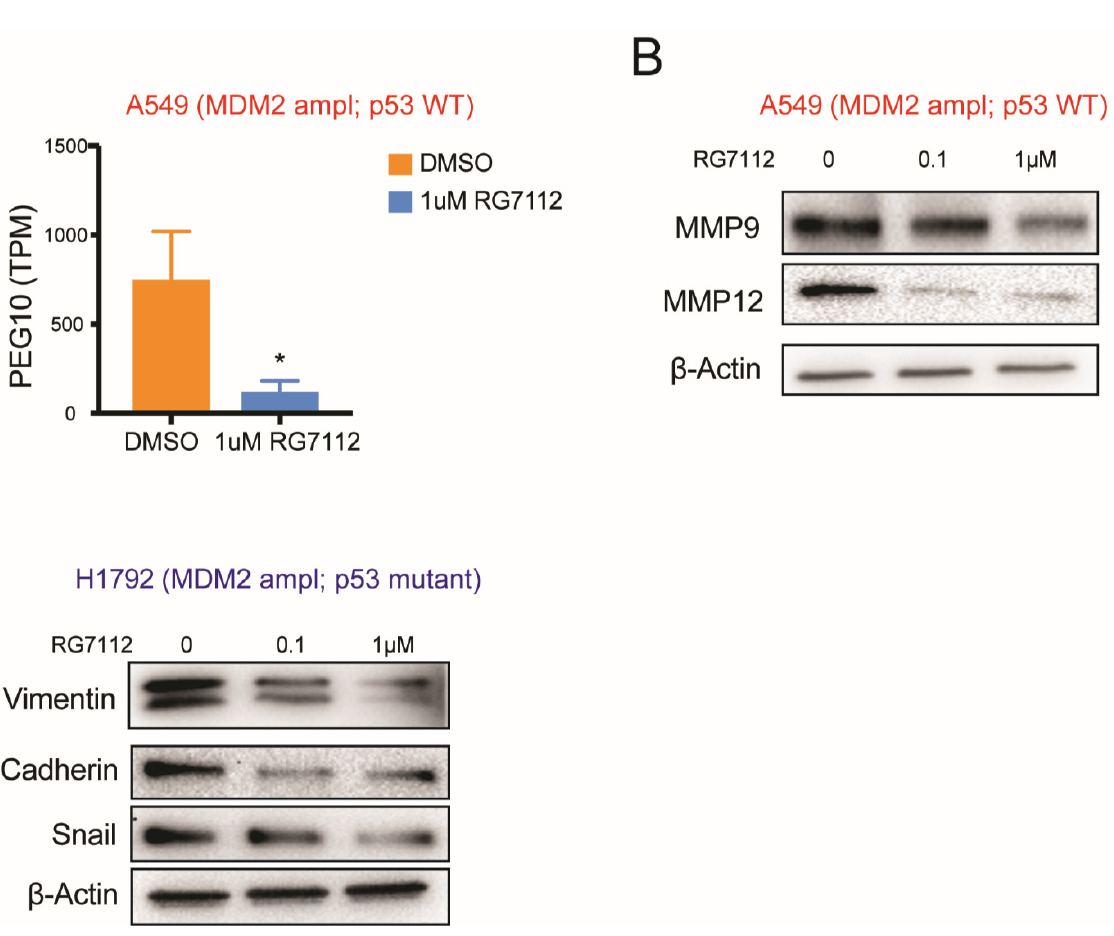
Figure 6. MDM2 ‐ targeted therapy suppresses tumor invasiveness by targeting E2F → PEG10 → Figure 6. MDM2-targeted therapy suppresses tumor invasiveness by targeting E2F → PEG10 MMP signaling axis and EMT signaling in p53 wild ‐ type and mutant condition, respectively. ( A ) → MMP signaling axis and EMT signaling in p53 wild-type and mutant condition,